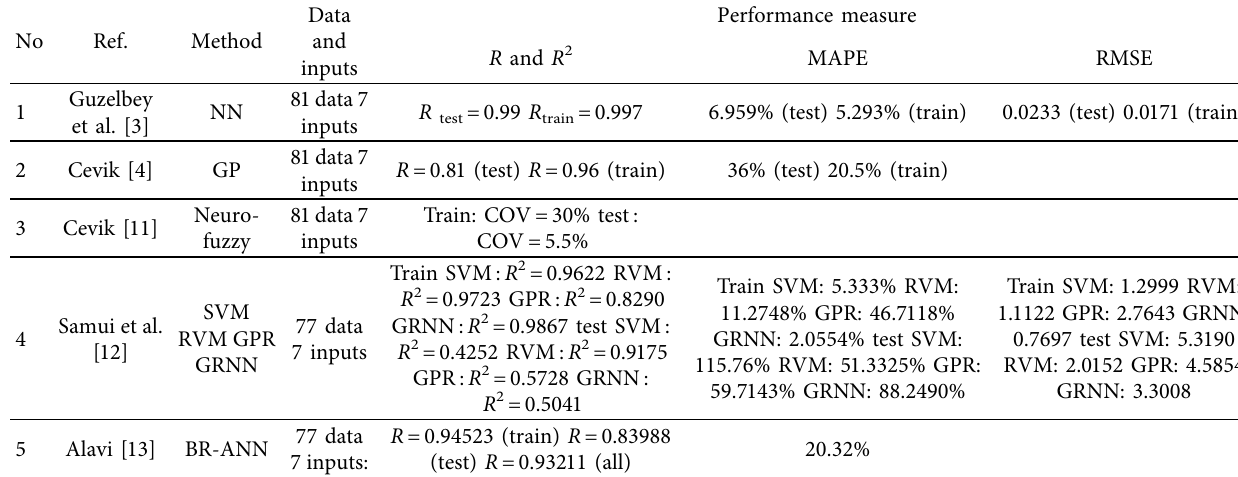
Table 1: Summary of research findings related to ML algorithms to predict the rotation capacity. No